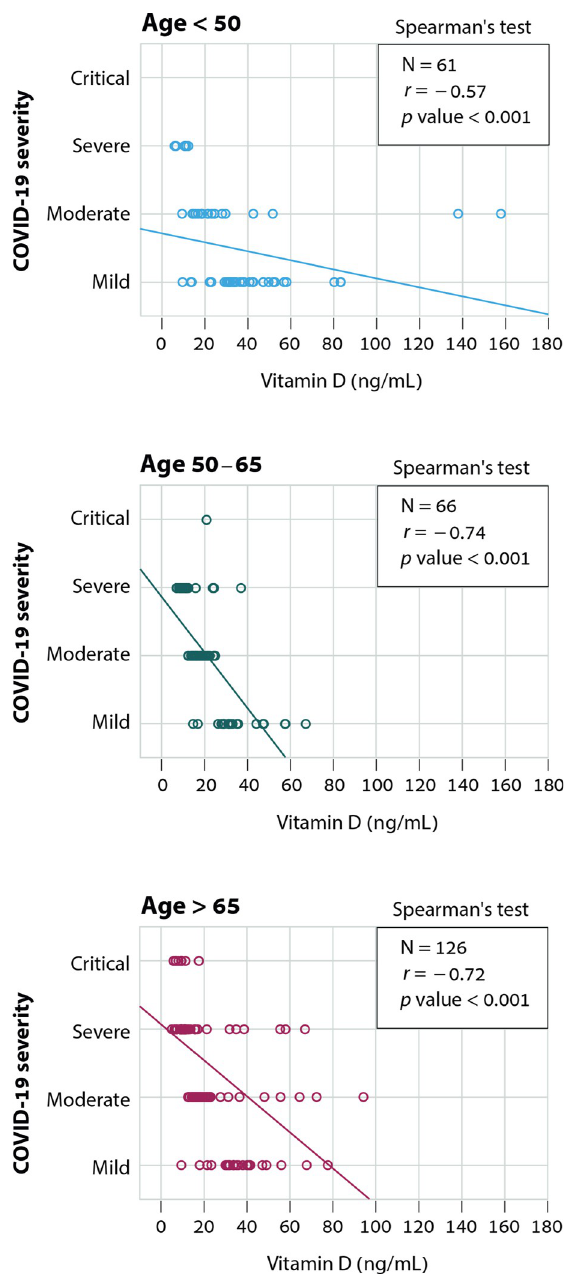
Fig 3. Correlation between pre-infection vitamin D deficiency status and COVID-19 disease severity stratified by three different groups of age ( < 50, 50–64, � 65). The severity of illness (critical, severe, moderate, and mild, as determined by the WHO definition of COVID-19 disease severity (WHO/2019-nCoV/clinical/2020.5)). The regression fit for each age group is shown. Values that are more than two SD away from the regression fit to the rest of the data were omitted from the analysis (applicable for two values appear on < 50 yr graph that omitted from regression fit calculation).